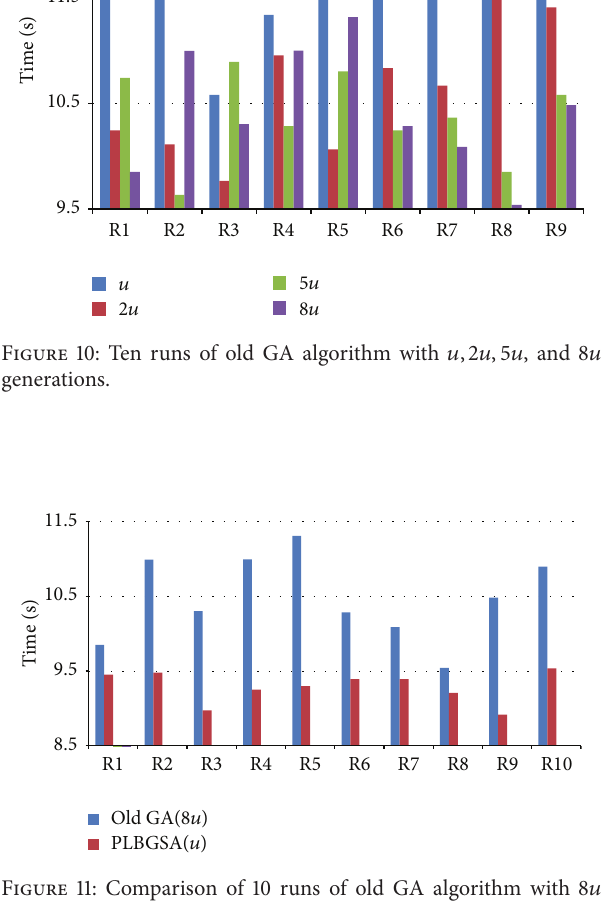
Figure 11: Comparison of 10 runs of old GA algorithm with 8𝑢 generations and PLBGSA with 𝑢 generations.